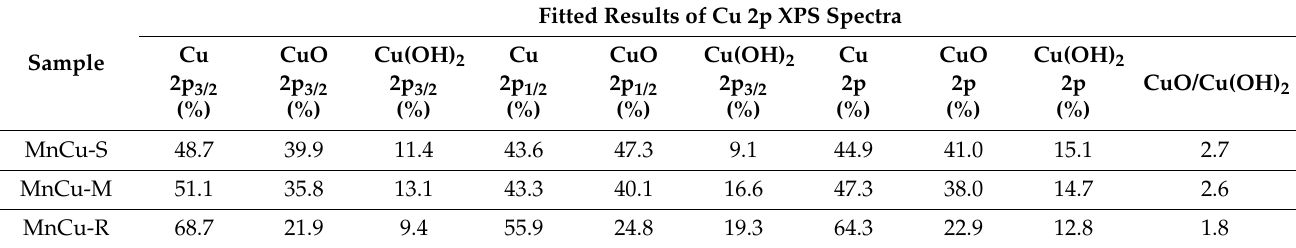
Table 6. Fitted Cu 2p 1/2 and Cu 2p 3/2 XPS spectra results of MnCu-R, MnCu-M, and